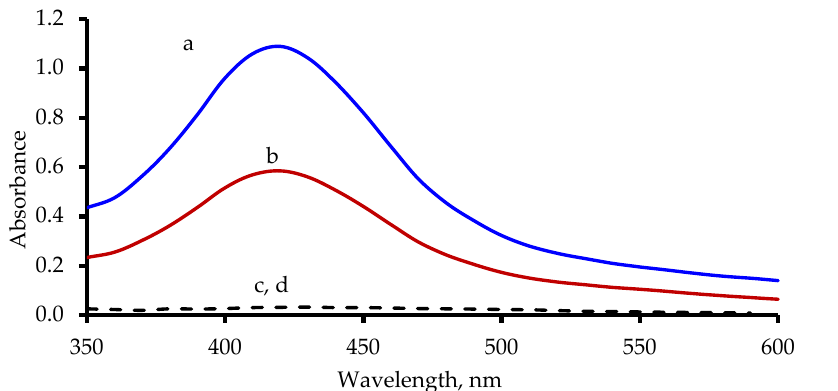
Figure 4. Evaluating the peroxidase activity for PVP-AgNPs on an OPD/H 2 O 2 system by fluores- cence technique; ( a ) excitation spectrum for ox-OPD and ( b ) emission spectrum for ox-OPD.